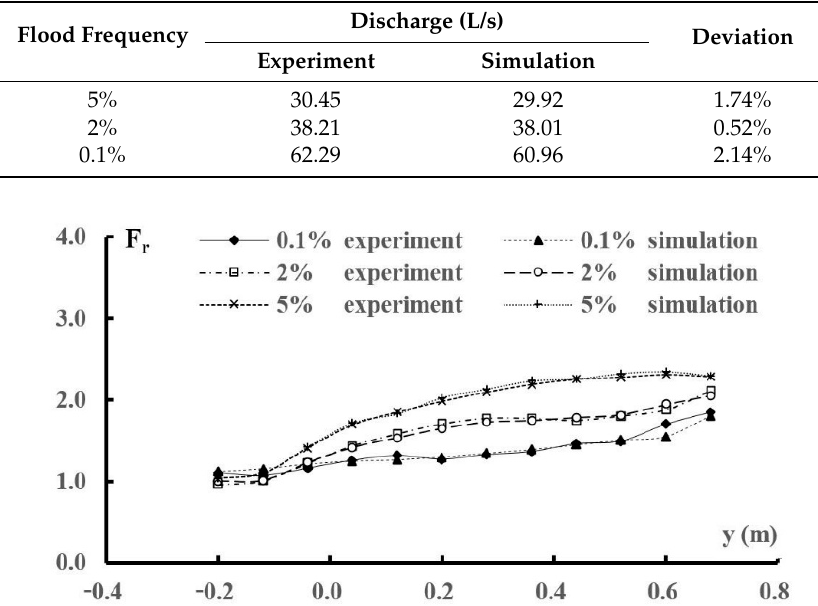
Table 2. Comparison of discharge between experiment and simulation.